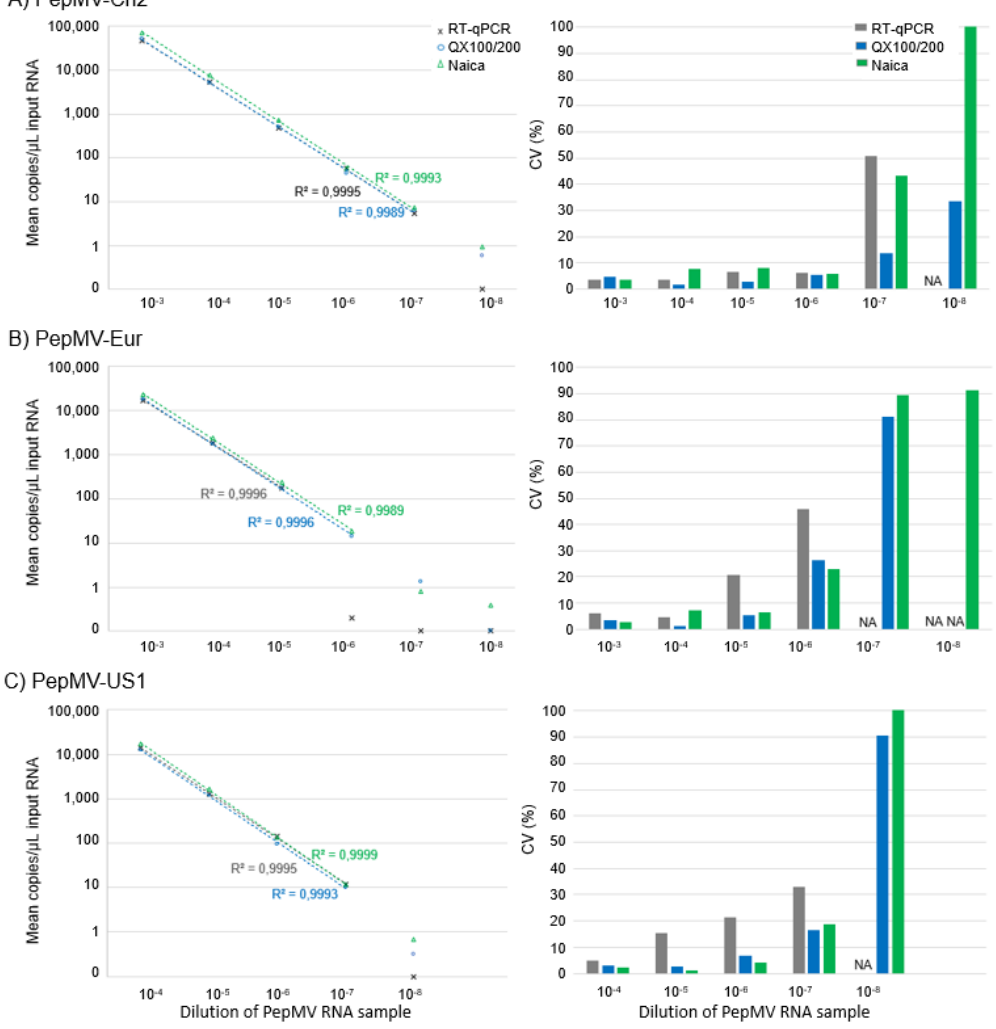
Figure 3. Parallel PepMV-genotype-specific RT-dPCR (blue, QX100/200; green, Naica) and RT-qPCR (grey) analyses of the different genotypes of PepMV RNA. Left: correlations between serial dilutions and concentrations of PepMV RNA determined ( n = 3, for each dilution and each method). Linear regression is plotted for each genotype tested with each method, with the correlation coefficients ( r 2 ) given. Right: precision of the assays, as CV (%) of the PepMV RNA copy numbers measured. NA, not applicable (below the limit of detection).